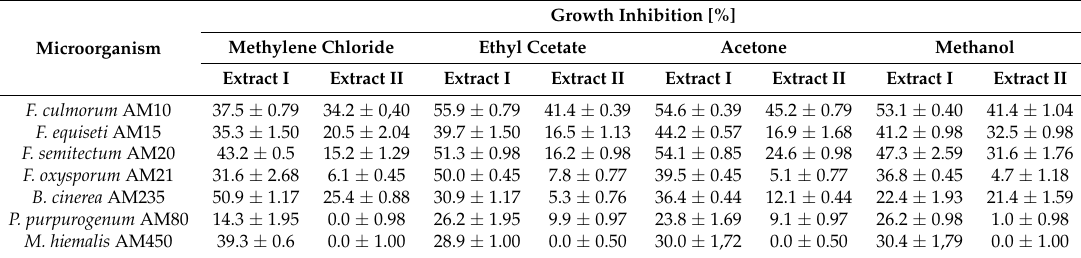
Table 3. Antifungal activity of the spent hops extracts (type I) and the residues of the spent hops extracts obtained after xanthohumol removing (type II) determined at 1 mg/mL concentration.